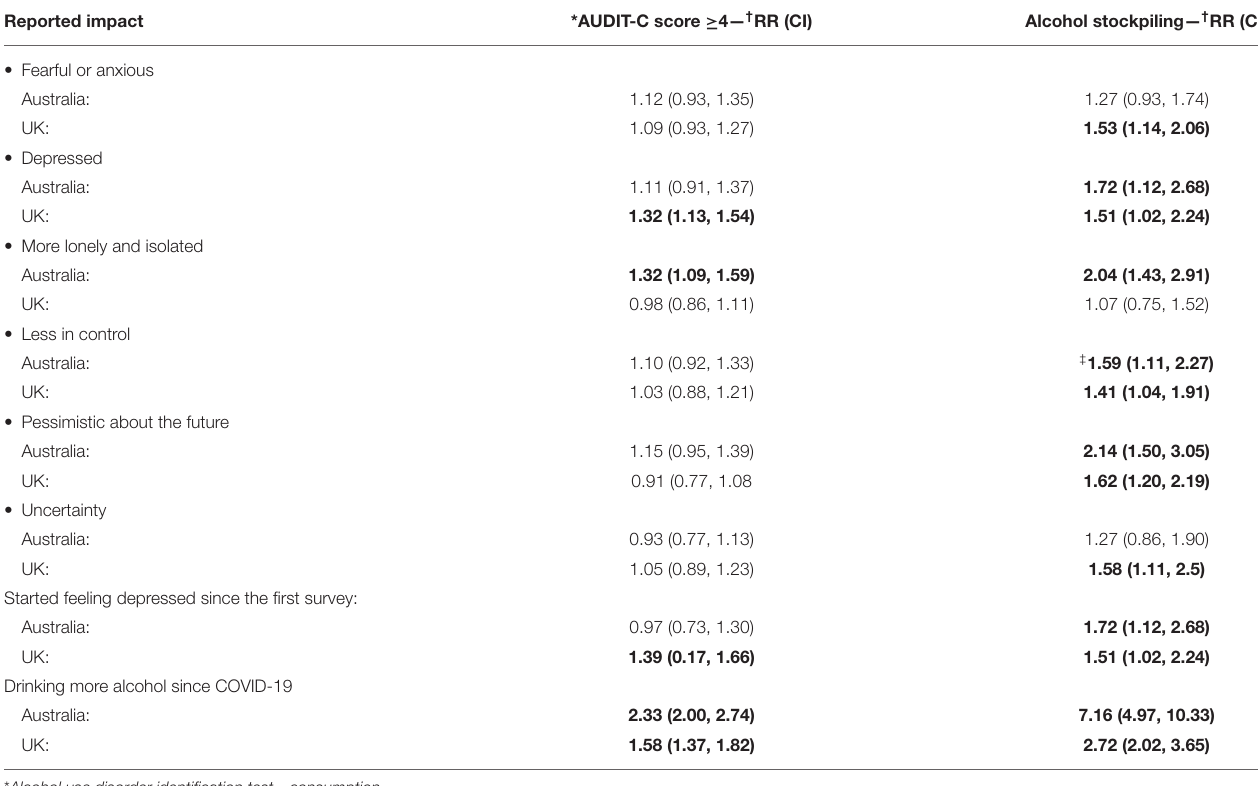
TABLE 3 | Selected COVID-19 impacts in the second survey, problematic drinking, and alcohol stockpiling ( N = 1,377). Reported impact